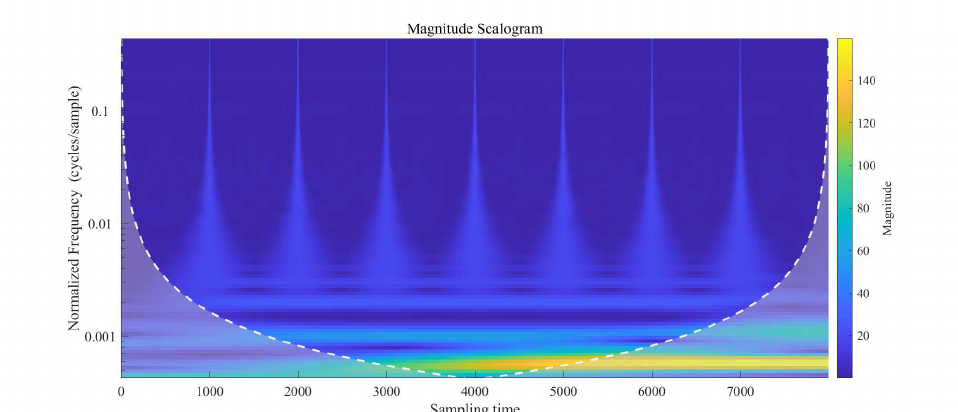
Figure 10. The time-frequency domain property of current signal i a .